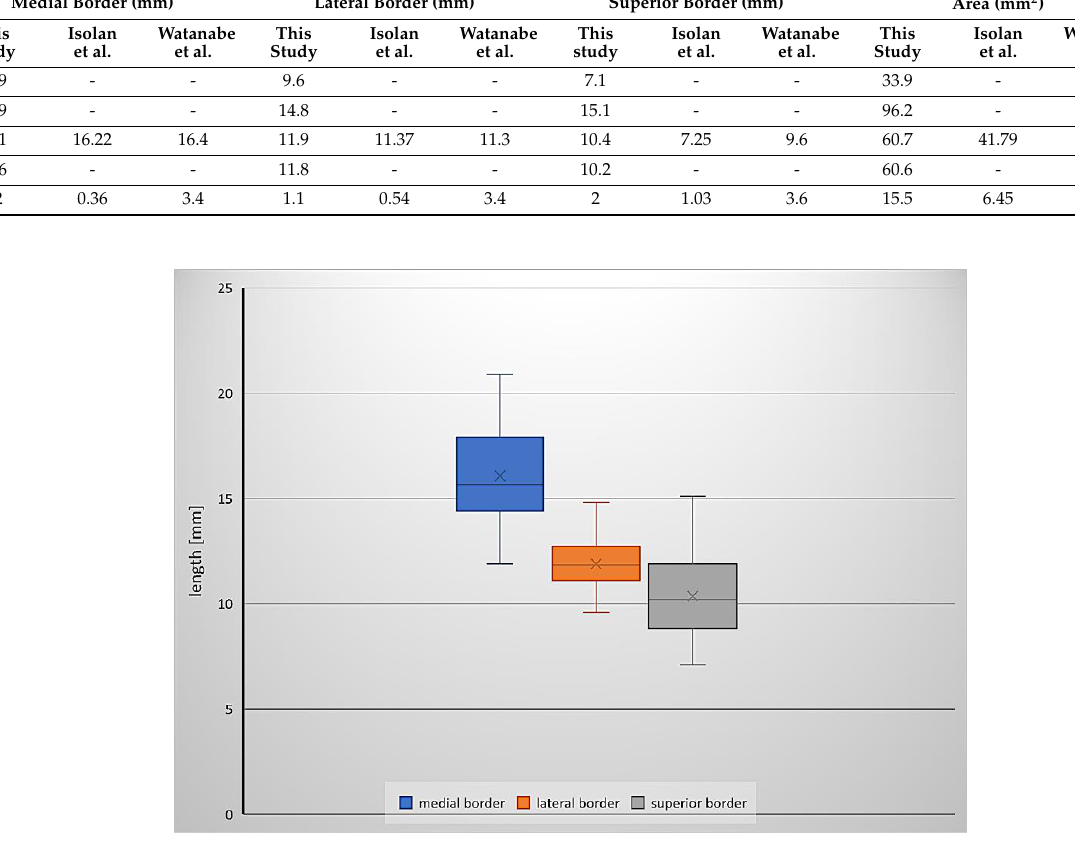
Figure 1. A box plot depicting the border lengths of the inferomedial triangle.